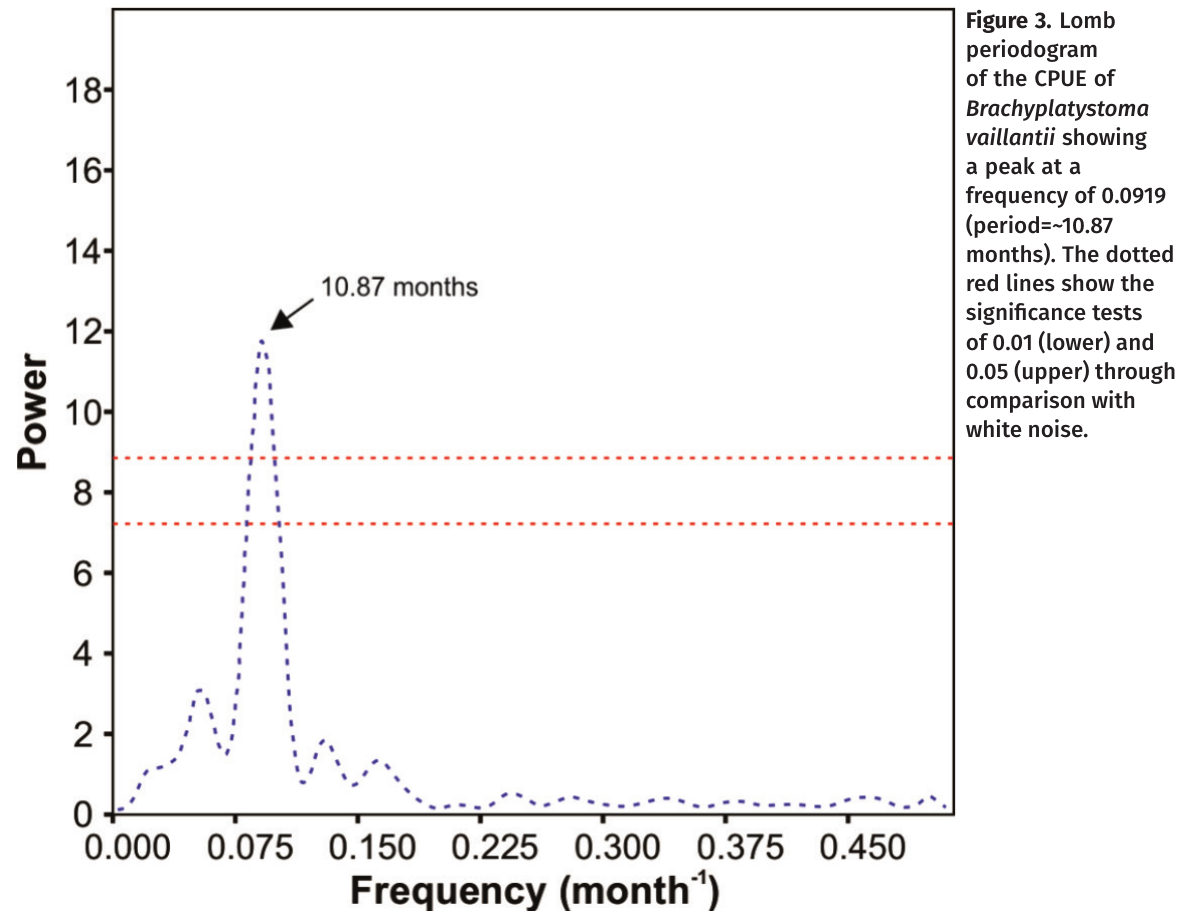
Figure 2. Variation of CPUE 1 average per month of Brachyplatyatoma vaillantii , from February 2008 to September 2011.